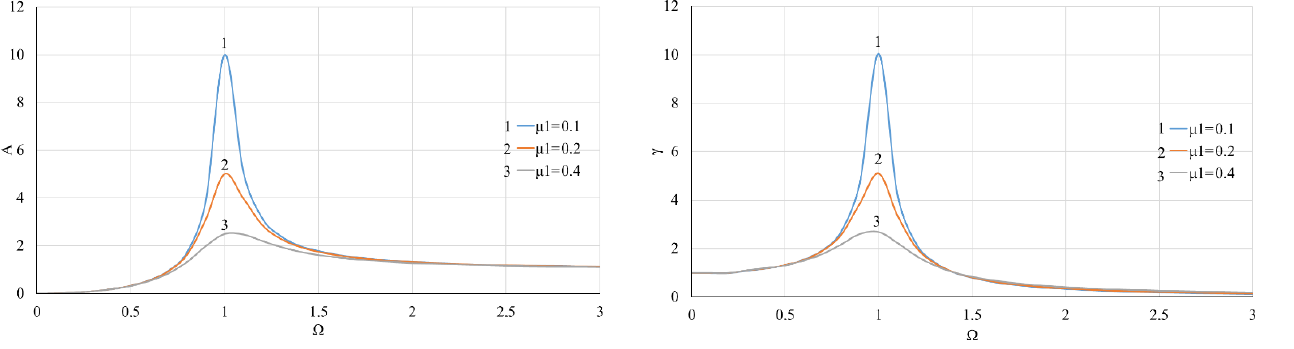
Figure 5. Dependence of the moment of force transmissibility of the system γ on the rotor velocity (cid:127) with linear stiffness of the support and at different values of the coefficient of linear viscous damping µ 1 .